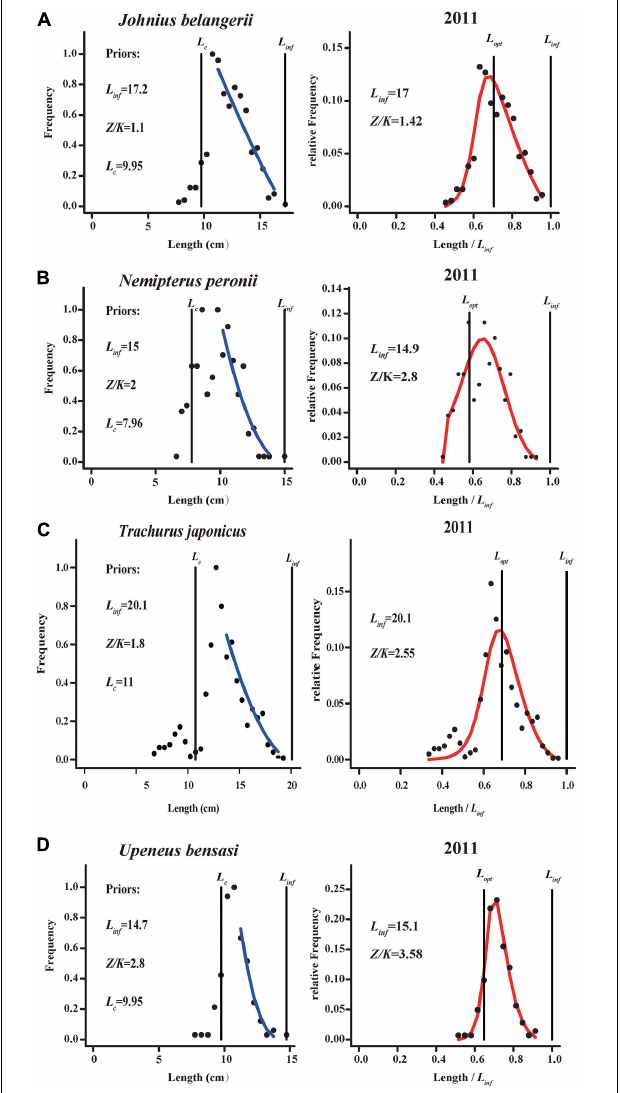
FIGURE 5 | The assessment results of four “healthy” species with LBB method in Beibu Gulf. (A–D) Presents the result of Johnius belangerii